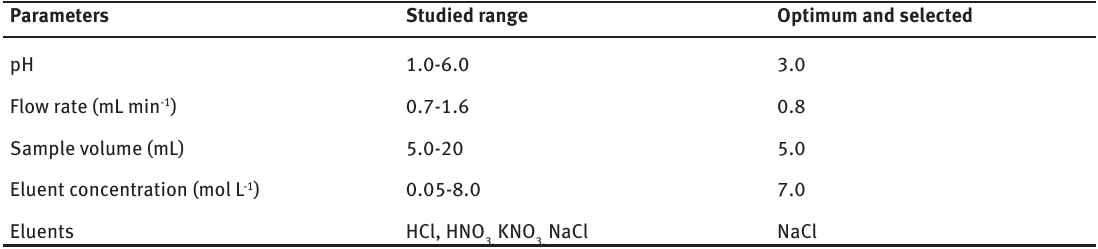
Table 1: Optimization of different parameters in Flow injection system.